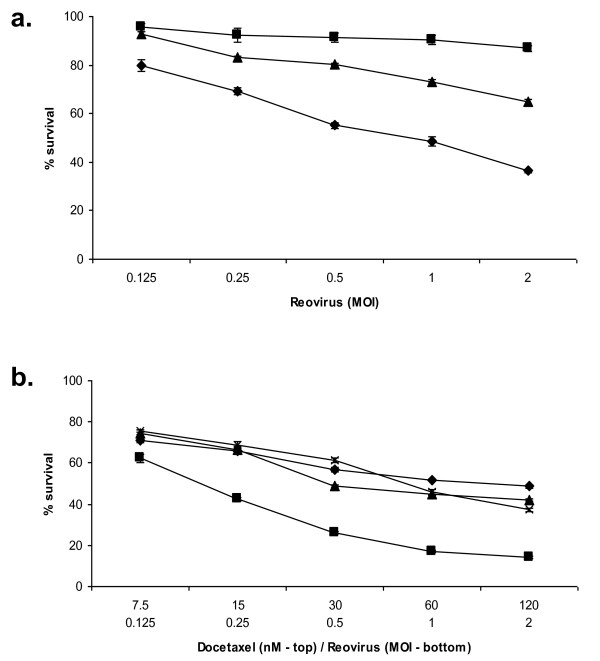
Live virus is required for efficient cell kill and enhanced cell kill with docetaxel. PC3 cells were treated with live (diamonds), heat-inactivated (squares), or UV-inactivated (triangles) virus for 48 h at the MOI indicated at which point survival was measured by MTS assay (a). PC3 cells were also treated with docetaxel alone (diamonds), or docetaxel with live reovirus (squares), heat-inactivated reovirus (triangles) or UV-inactivated virus (crosses) for 48 h at the concentration and MOI indicated. Survival was measured at this time by MTS assay. The combination of live reovirus with docetaxel enhanced cell kill compared with docetaxel alone (P < 0.0001, two-way ANOVA), however this enhancement of cell kill was not apparent when heat inactivated or UV-inactivated reovirus was used (b). Data for both are normalized to uninfected controls (MOI 0) and are representative of three independent experiments.